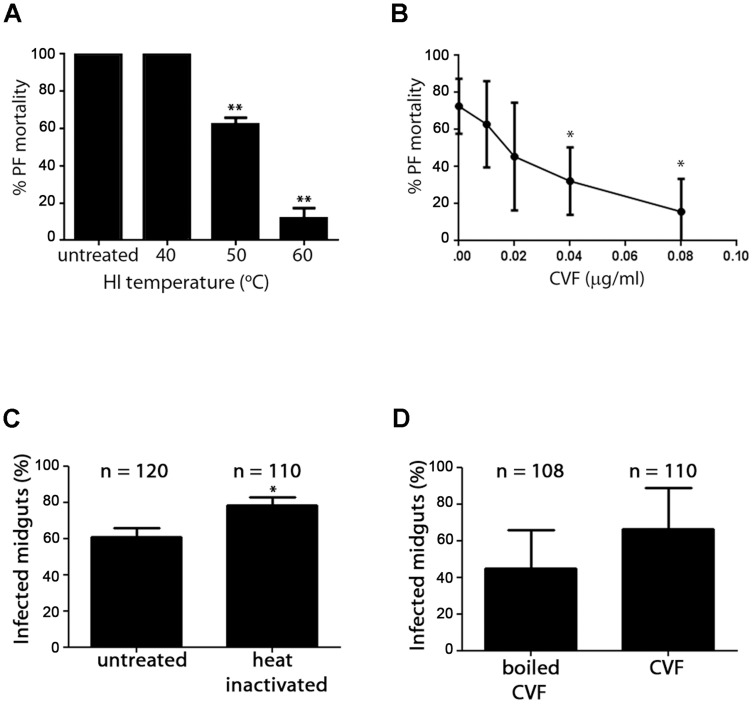
HS complement is lethal to PFs.(A) The lethality of HS can be inactivated by pre-treating the serum with heat. PF mortality decreases significantly when HS is heat inactivated at 50°C for 1 h, and up to 88.5±5.67% survive when the temperature of inactivation was 60°C. (B) PF lysis by HS decreases when HS was pre-treated with CVF to exhaust complement cascade factors. (C) Tsetse infection experiments carried out using heat inactivated serum resulted in a significant (P = 0.01) increase in infected midguts in experimental groups where heat inactivated serum was used for infection and feeding. (D) A similar increase in infection rate was observed when the HS used in experiments was pre-treated with CVF, though this increase was not statistically significant compared to tsetse that were infected and maintained with HS pre-treated with boiled CVF after 4 experimental replicates.